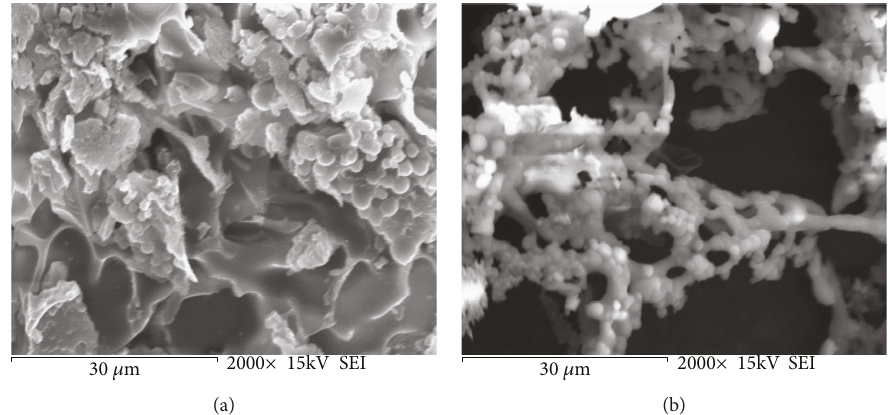
Figure 4: Scanning electron microscopy (SEM) micrographs of wheat-gluten proteins soluble in ethanol (WGPSE) microparticles with 2000x magni fi cation; (a) without urea and (b) loaded with urea.